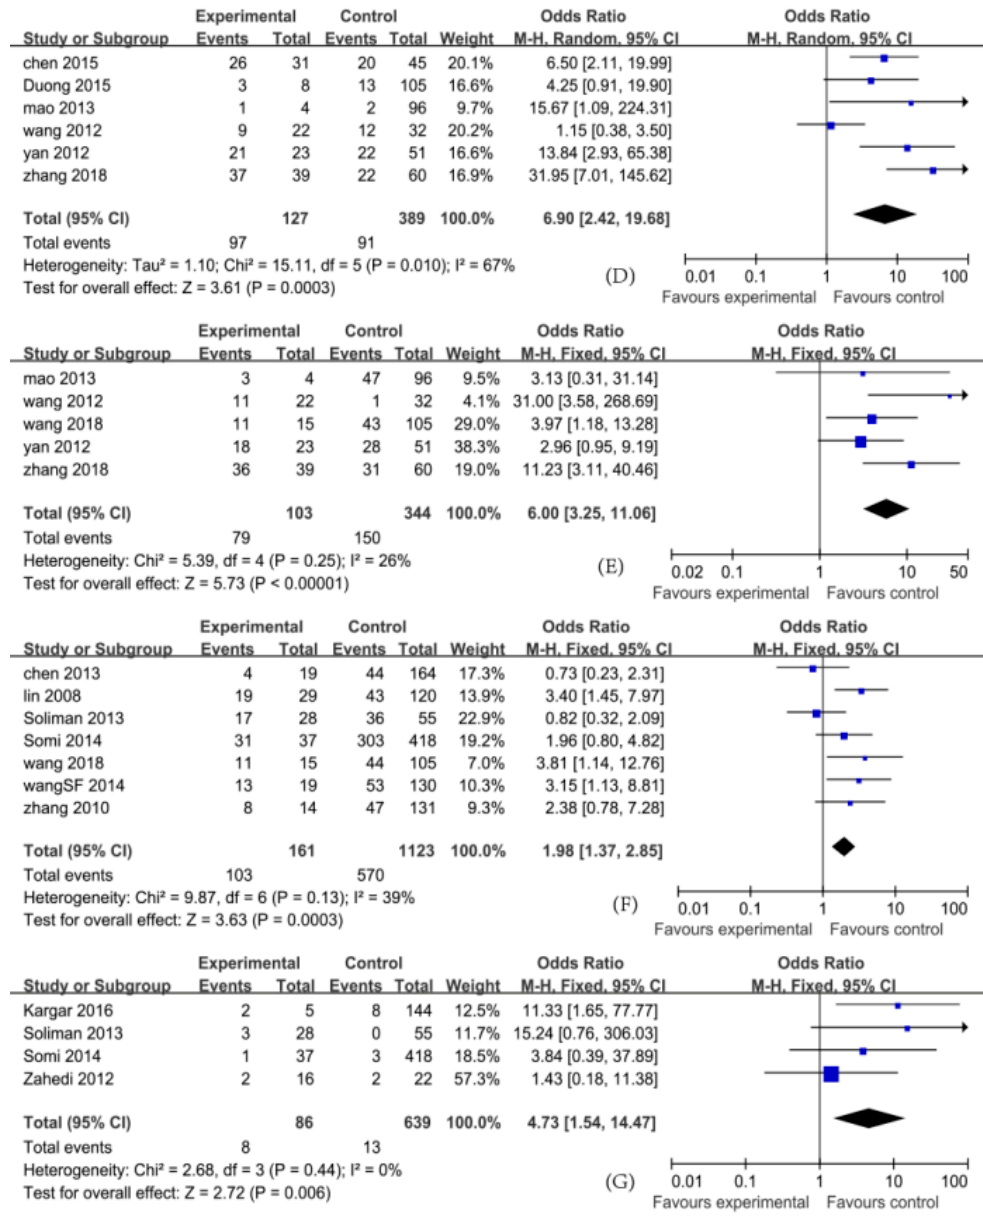
Figure 3. E ff ects of pooled ORs for factors correlating to the development of hepatitis C virus infection in hemodialysis patients (( D ) hemodialysis units > 2; ( E ) weekly hemodialysis times > 2; ( F ) a history of surgery; ( G ) drug addiction).